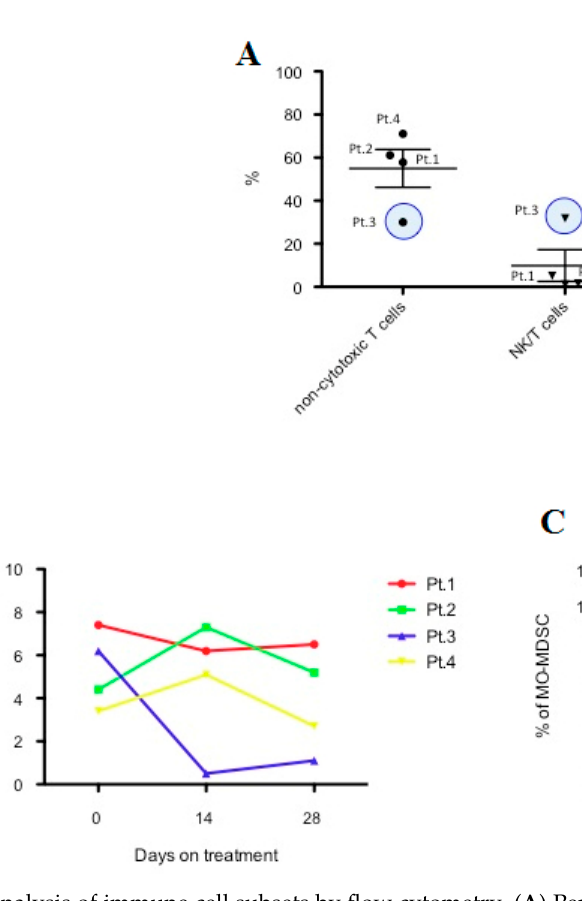
Figure 4. Analysis of immune cell subsets by flow cytometry. ( A ) Percentage of noncytotoxic T cells and NK/T cells at baseline. ( B ) Percentage of nonclassical monocytes over the course of therapy with nivolumab (at baseline, after 14 and after 28 days). ( C ) Percentage of monocytic myeloid-derived suppressor cells (MO-MDSC) over the course of therapy with nivolumab (at baseline, after 14 and after 28 days). Analysis was performed in the first four patients. Numbering of patients in the three panels is the same as reported in Table 2.